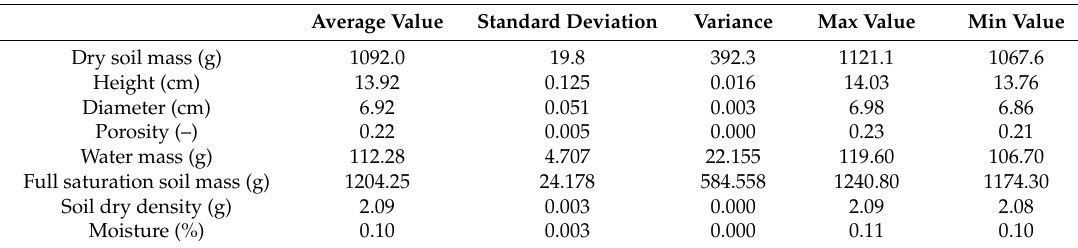
Table 3. The stress parameters of